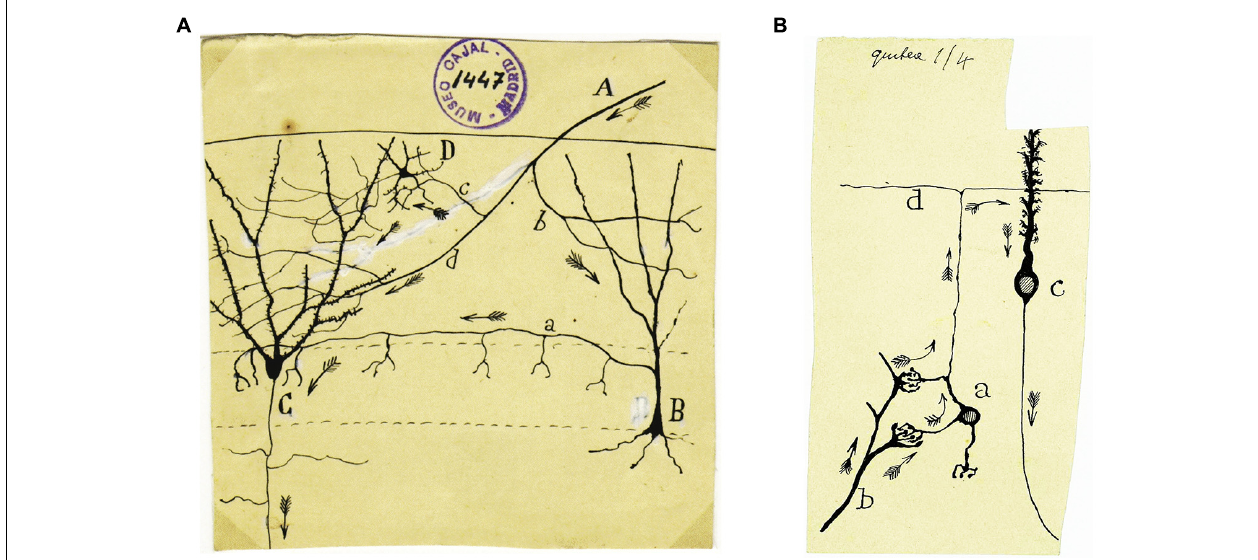
the nervous movement well, it is difficult to understand how such elements increase the energy of the discharges ” (Ramón y Cajal, 1904). (B) In this drawing Cajal represents the cerebellar circuit in a very simple but accurate way, showing the direction of the nerve impulse with Indian arrows. Basically, from the pontine nuclei, the mossy fibers reach the cerebellum and transmit information to the granular cells. These cells conduct this information through their axons, the parallel fibers, towards the Purkinje cell dendrites, and finally, it is these cells that project the nerve impulse out of the